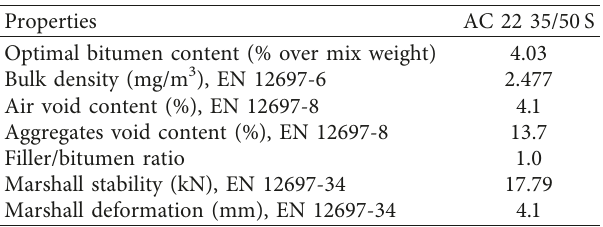
Table 3: Main physical and mechanical characteristics of the HMA used as a